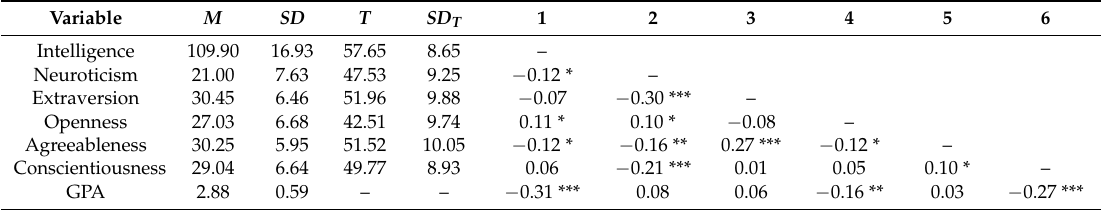
Table 1. The means ( M ), standard deviations ( SD ), T values, the standard deviation of T values, and intercorrelations for intelligence, the Big Five personality dimensions, and grade point average (GPA).